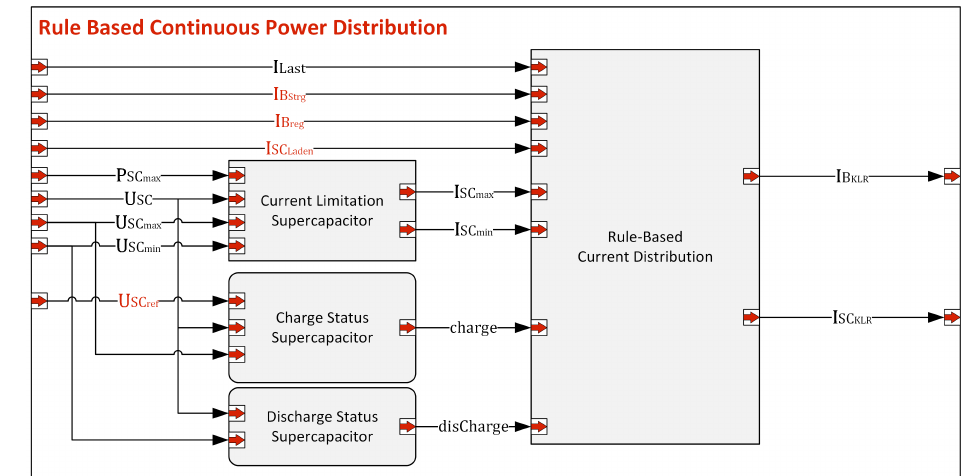
Figure 4. Rule-based distribution of load current to battery and